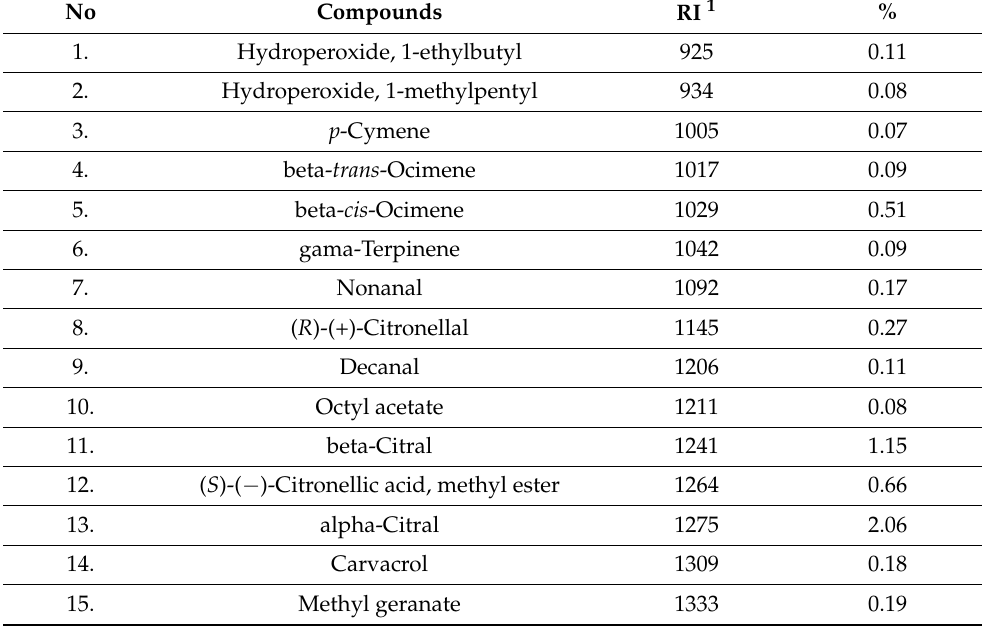
Table 2. Chemical composition of M. officinalis subsp. officinalis essential oil analyzed by GC–MS.